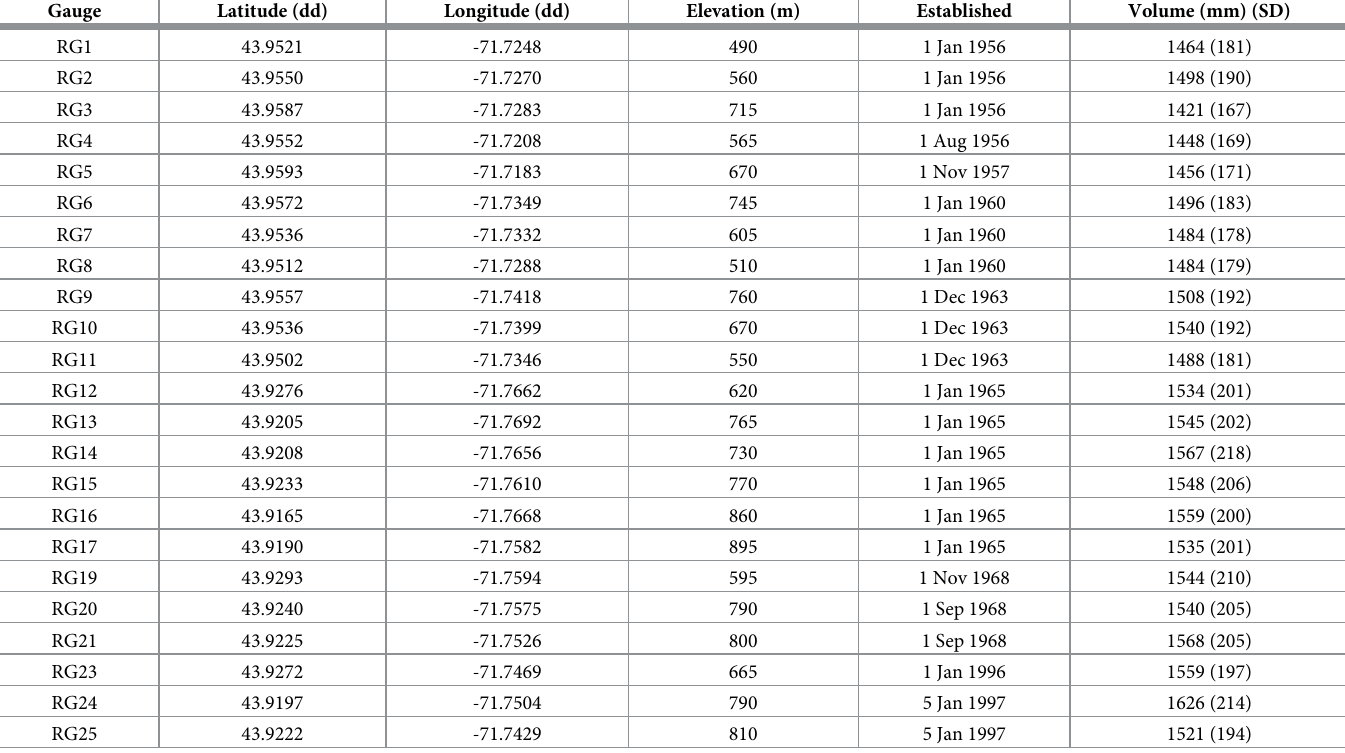
Table 1. Location, elevation, and date of establishment of precipitation gauges at the Hubbard Brook Experimental Forest, New Hampshire, USA. Volume is the average annual precipitation from 1998 to 2014. Note that RG18 was decommissioned in 1975. RG22 is not included in this analysis because it is located far from the gauged catchments (at the U.S. Forest Service headquarters). Thus there are 23 precipitation gauges in this study. Gauge Latitude